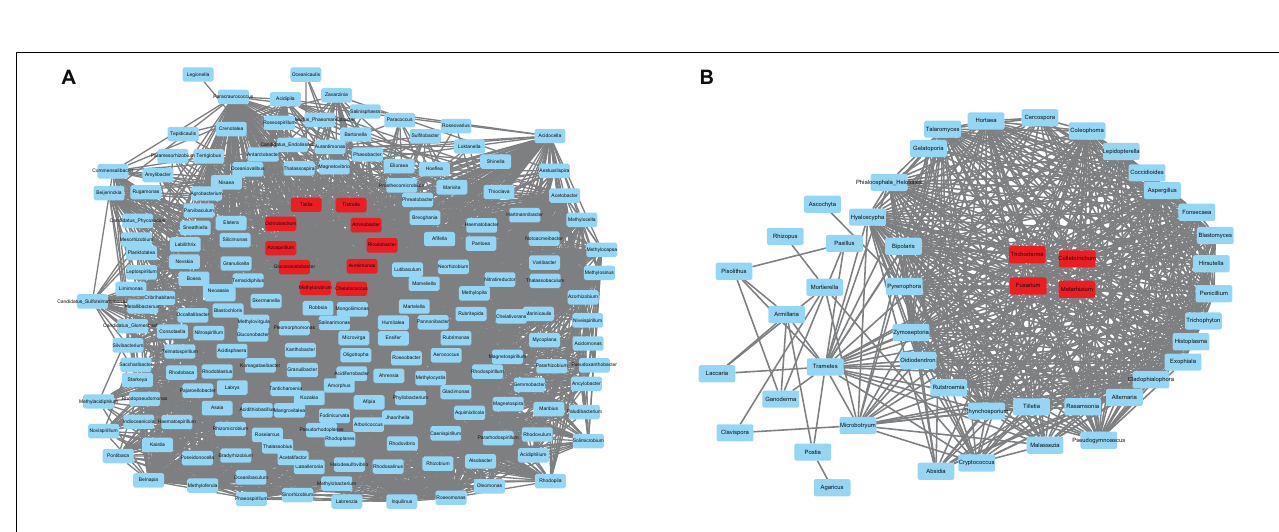
FIGURE 8 | The co-expression network. (A) The co-expression network of the hub genera from pink module in prokaryotes, including 100 nodes. (B) The co-expression network of the hub genera from turquoise module in fungi, including 48 nodes. The hub genes are represented in red color.